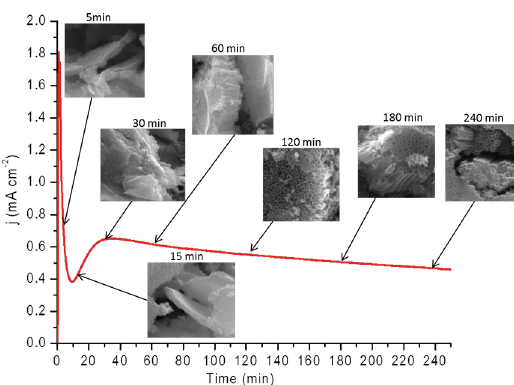
Figure 1. Current density-time behavior for titanium anodized at 60 V in 0.25 g NH F and 2 g H O for 240 4 2